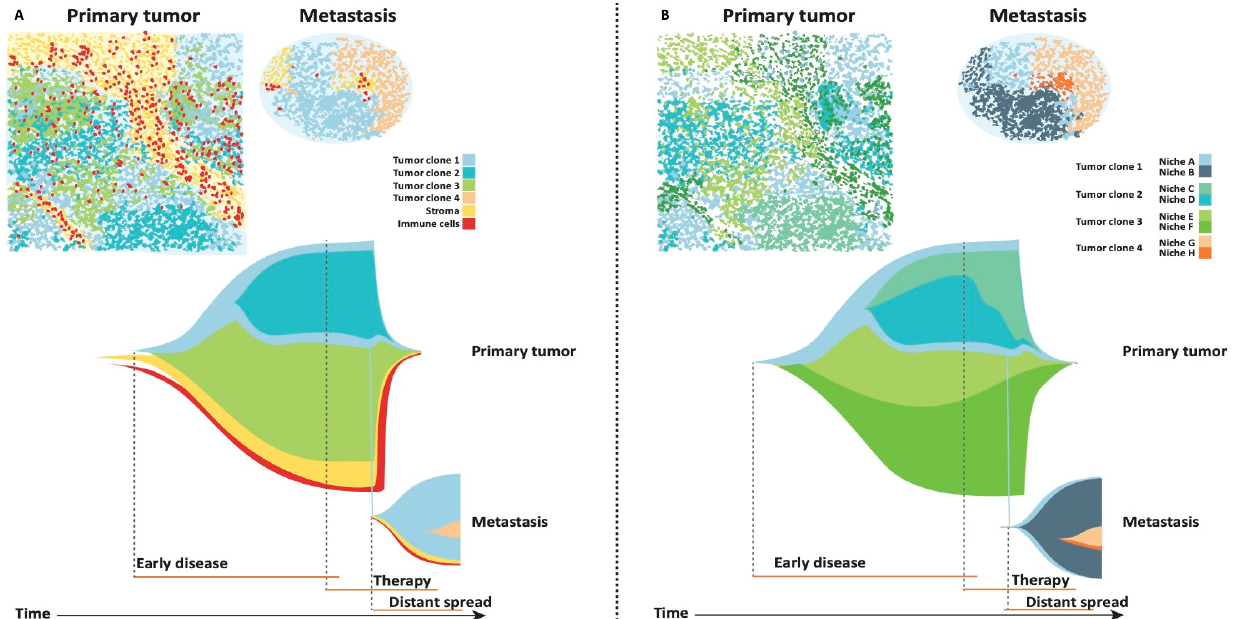
Figure 2. Evolution of tumor cells and the tumor micro-environment (TME) in TNBC. ( A ) An inflamed-SI tumor with four tumor clones, stroma, and immune cells illustrated. The evolution of the compartments is visualized below (evolution figure adapted from Sun, Zheng, and Curtis, 2018) and spans from early disease, during therapy to distant spread. The primary tumor consists of 3 tumor clones. The clones are surrounded by stroma and immune cells. Typically, these compartments are described separate since methods to reconstruct tumor evolution are based on genomic heterogeneity amongst tumor subclones and lack direct information regarding immune evolution. ( B ) Here, the same tumor is illustrated, however tumor subclones and the surrounding stroma and immune cells are instead clustered into ecological niches, revealing their topography within the tumor-immune microenvironment. Such spatially-resolved cellular maps may provide insight into why some subclones expand, whereas others are spatially restricted, thereby informing patterns of metastatic "spread" and "therapy response" in TNBC and will be enabled by scalable spatial genomics techniques. Spread: Clone 1 disseminates to distant sites and form a macro metastatic lesion. Under (Niche A) clone 1 can be found in both the primary tumor and metastasis. Under (Niche B) the same tumor clone ("1") escapes but now we can observe that the tumor microenvironmental niche in the metastasis changes quickly (from Niche A in light grey, to Niche B in dark grey), indicating that the clone is the same but the micro-environment drastically changes, potentially leading to a more aggressive phenotype. Therapy response: In the primary tumor clone 2 and 3 both show different microenvironmental niches, which respond differently to, e.g., therapy. For example, tumor clone 2 (Panel A) is divided in Niche C and D (Panel B), where the niches show differential response to therapy. Niche D rapidly decreases during therapy, whilst Niche C is less sensitive and persists longer. Consideration of the tumor-immune microenvironment during tumor progression may enhance our understanding of the evolutionary dynamics and drivers of tumor